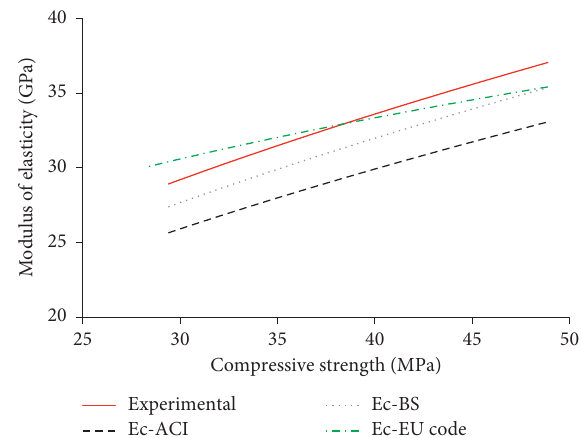
Figure 19: Comparing the developed empirical equation of E the standard codes of Figure 18. The developed equation is a power equation and